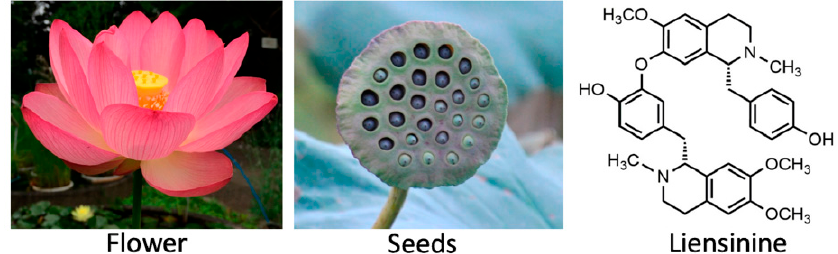
Figure 1. The flower and seeds of Nelumbo nucifera and the chemical structure of